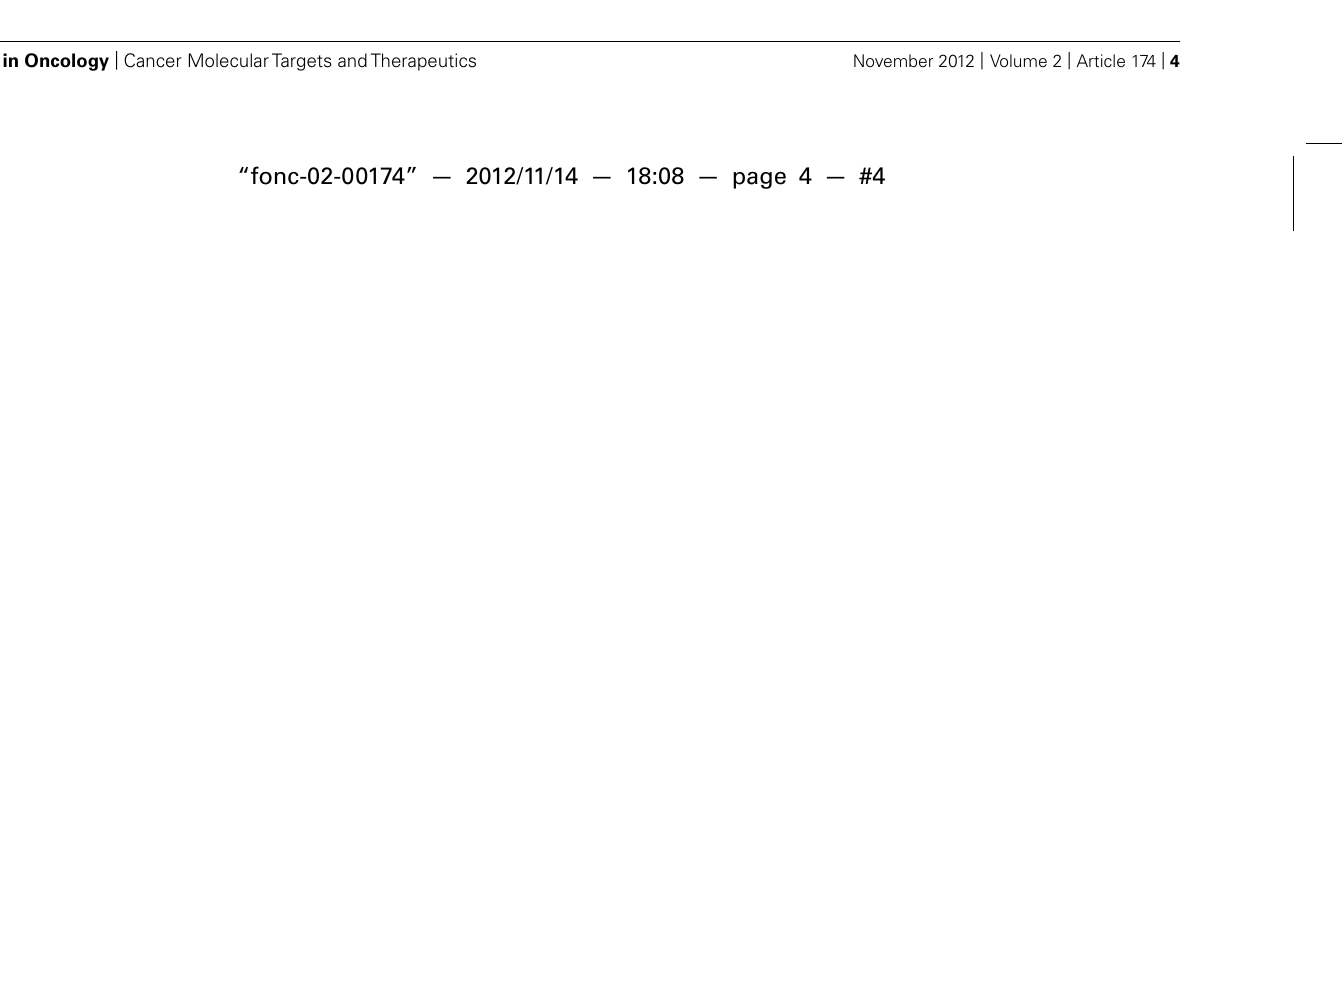
MYCN amplification (multiple red signals). (B) Two RBCs are in the open lumen of the NB-derived endothelial micro-vessel. Nuclei are stained with DAPI (blue), ×